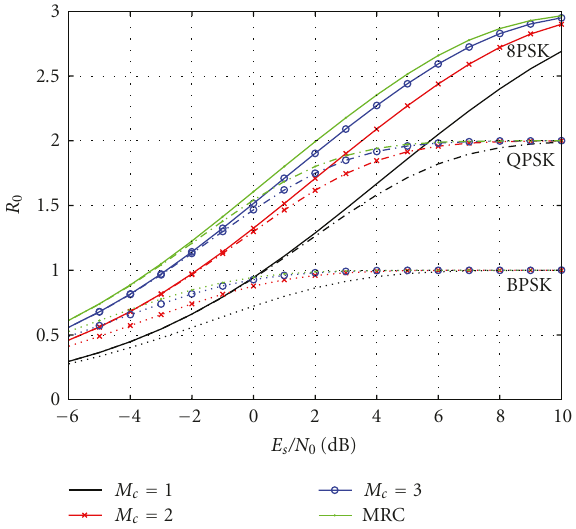
Figure 1: Cuto ff rate of coded GSC with M = 4 and di ff erent number of selected diversity branches in Nakagami fading with m = 2.